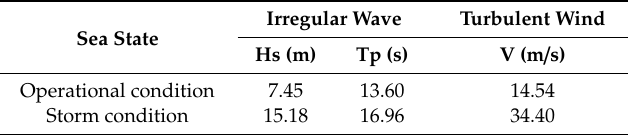
Table 6. Specific parameters of the two load cases.